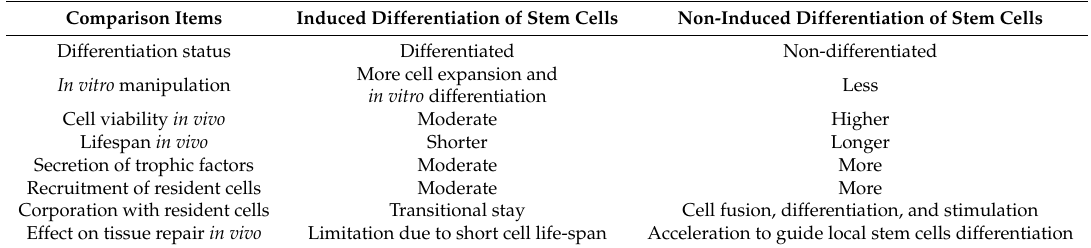
Table 2. Comparison of non-induced and induced differentiation of stem cells in tissue repair in vivo